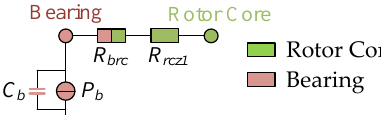
Figure 13. Bearing thermal model.